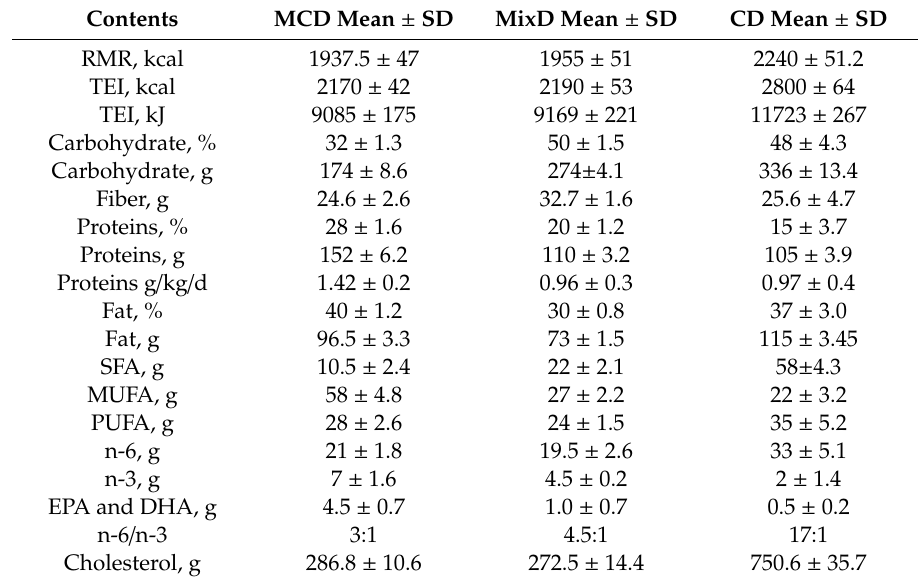
Table 1. Average macronutrients and total energy content of the moderate-carbohydrate diet (MCD), mix diet (MixD), and conventional diet (CD) reported during